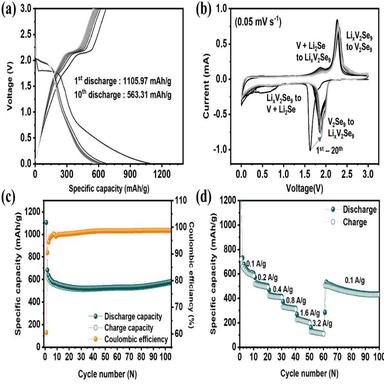
(a) Charge-discharge curve of V2Se9 at a current density of 0.1 A g− 1 . (b) CV curves of V2Se9 for the initial 20 cycles at a scan rate of 0.05 mV s − 1 . (c) Capacity retention and coulombic efficiency at a current density of 0.1 A g− 1 and a voltage range of 0.001–3.0 V. (d) Rate capability test at different current densities of 0.1, 0.2, 0.4, 0.8, 1.6, and 3.2 A g− 1 .